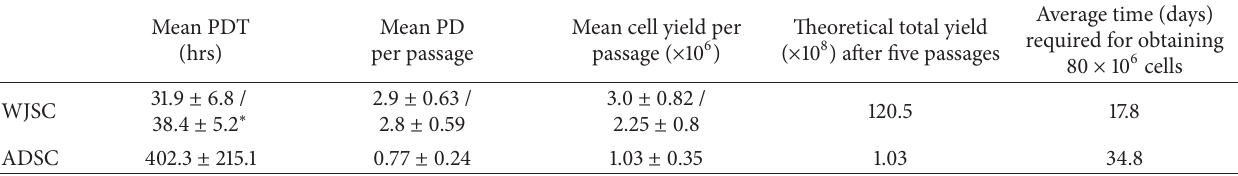
Table 2: Synopsis of proliferation kinetics data of WJSC and ADSC during long-term in vitro expansion.